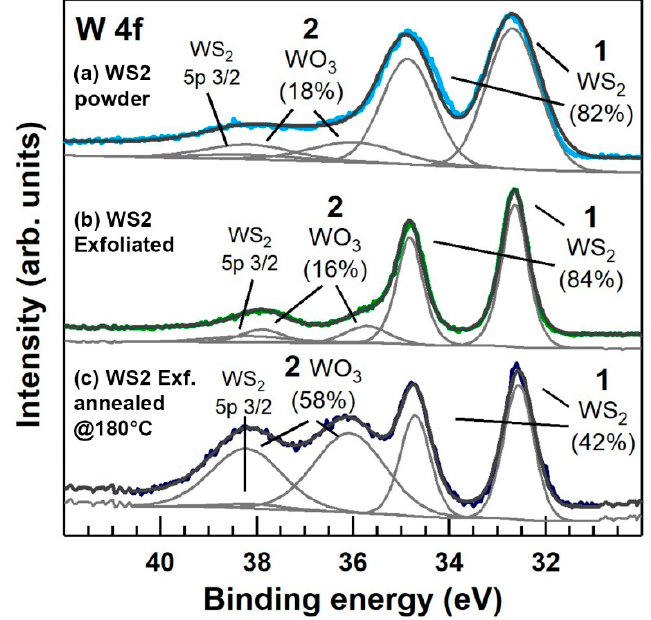
Figure 5. X-Ray Photoemission Spectroscopy (XPS) spectra of W 4f core level acquired respectively on ( a ) pristine WS 2 commercial powder (WS 2 PWD), ( b ) Exfoliated WS 2 by ball milling and sonication at 25 °C, ( c ) WS 2 exfoliated and post-annealed at 180 °C. All the components and their relative atomic percentages are labelled in the figure.